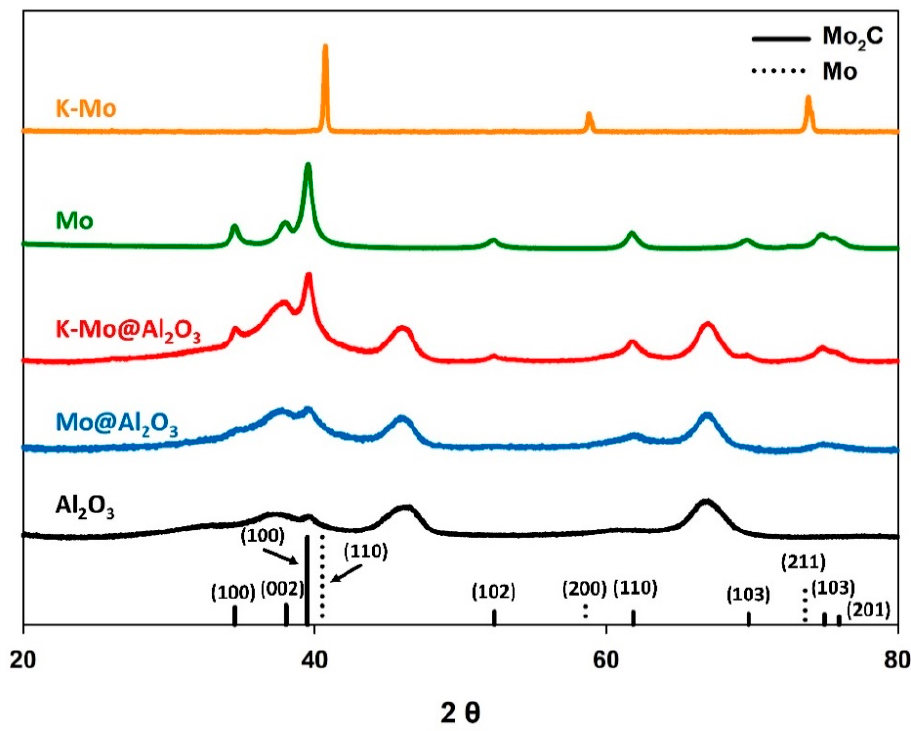
Figure 1. X-ray diffraction patterns for the various molybdenum-based catalysts, with and/or without the potassium promoter and γ -Al 2 O 3 support. Reference patterns are included for both Mo 2 C (solid line) and metallic Mo (dotted line), which are labeled with their corresponding Miller indices.